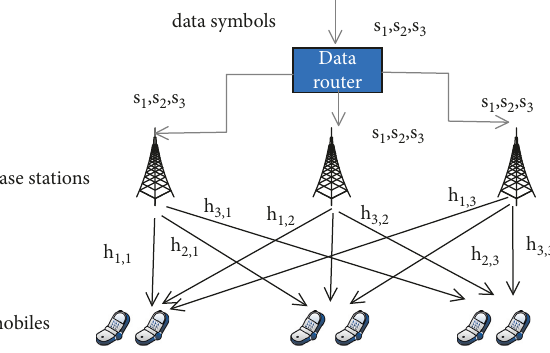
Figure 4: Schematic diagram of CoMPJP scenario. Table 5: Simulation parameter